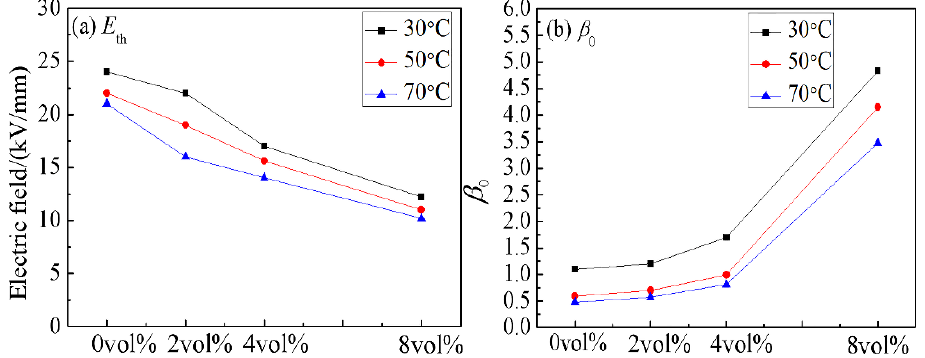
Figure 6. The nonlinear parameters of neat EPDM and CCTO/EDPM composites changes with temperature: ( a ) The threshold electric field E th ; ( b ) The nonlinear coefficient β 0.